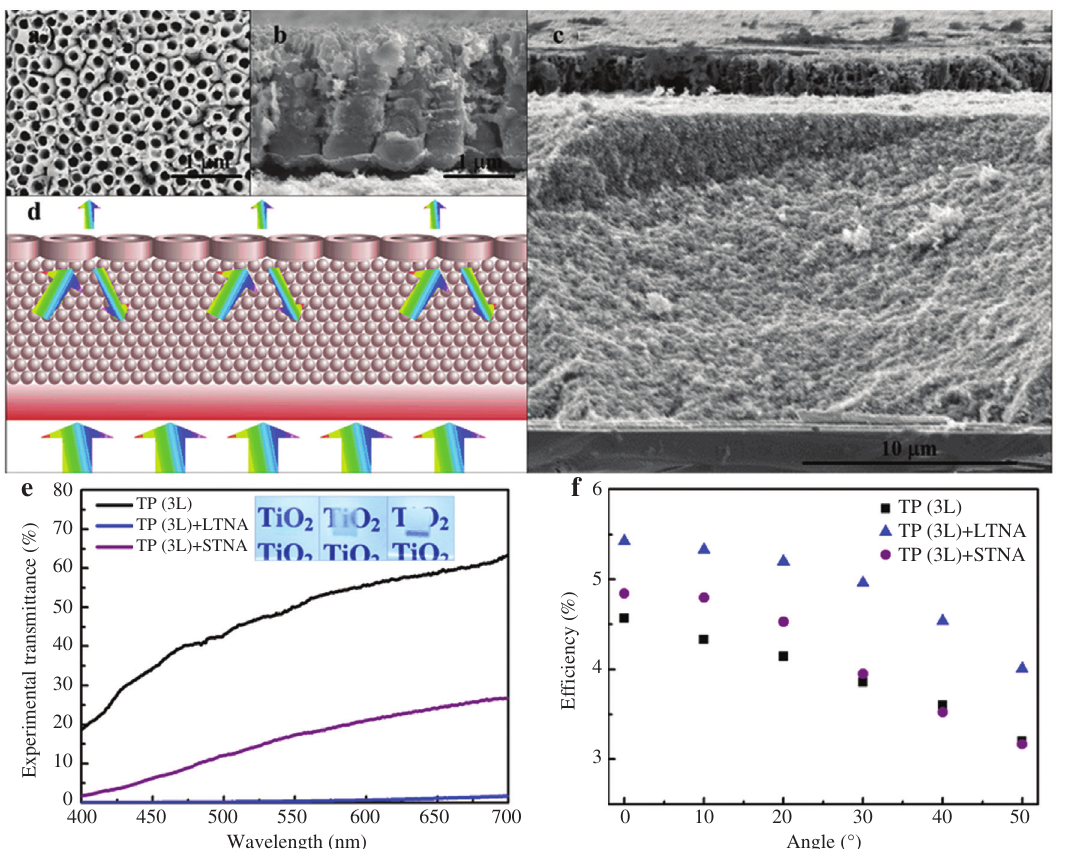
Figure 5E, and the corresponding microstructures of each layer are presented in Figure 5F–H. The synergetic effects of the individual component of the multi-layered struc- ture would lead to great improvement in solar cell perfor- mances [178]. Compared with the reference NP layer